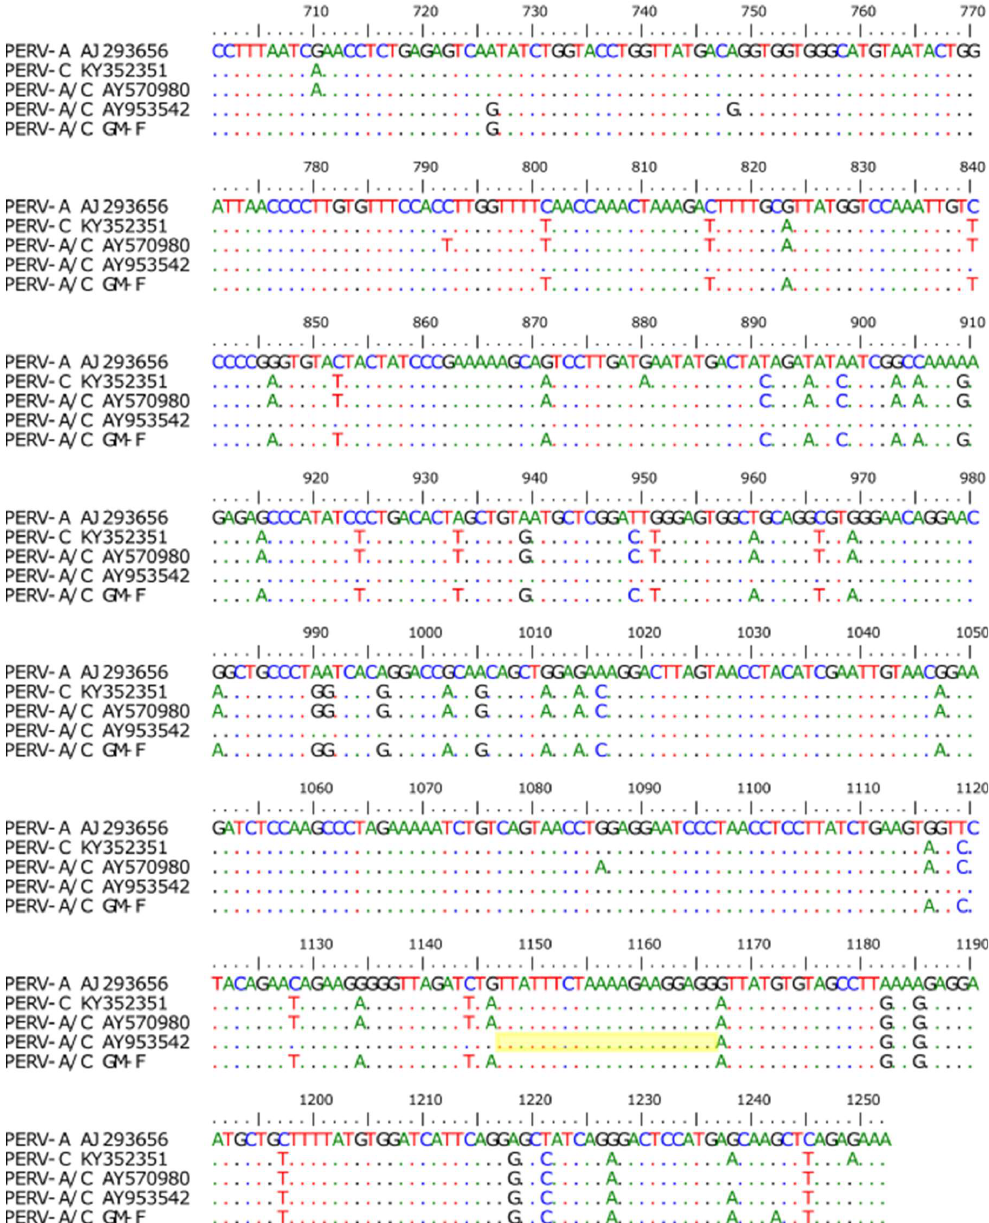
Figure 9. Sequence alignment of PERV-A, PERV-C, and two PERV-A / C, the PERV-A 14 / 220 described by Bartosch et al. [37] (AY570980) and the PERV-A / C 5 0 analyzed in our laboratory (AY953542) [9,23,38], as well as the virus isolated from GöMP F (GM-F). The primer PERV-A VRBF (blue line) and the primer PERV-C-TMR (not shown, ranging from nt 1288–1263) (Table 2) were used for amplification and sequencing of the PERV-A / C env sequence. The primer PERV-C rev (blue line) was also used for the detection of PERV-A / C (Figure 4). The sequences marked yellow represent the potential regions of recombination, the orange bar indicate an insertion. N, any nucleotide; M, A or C, W, A or T.